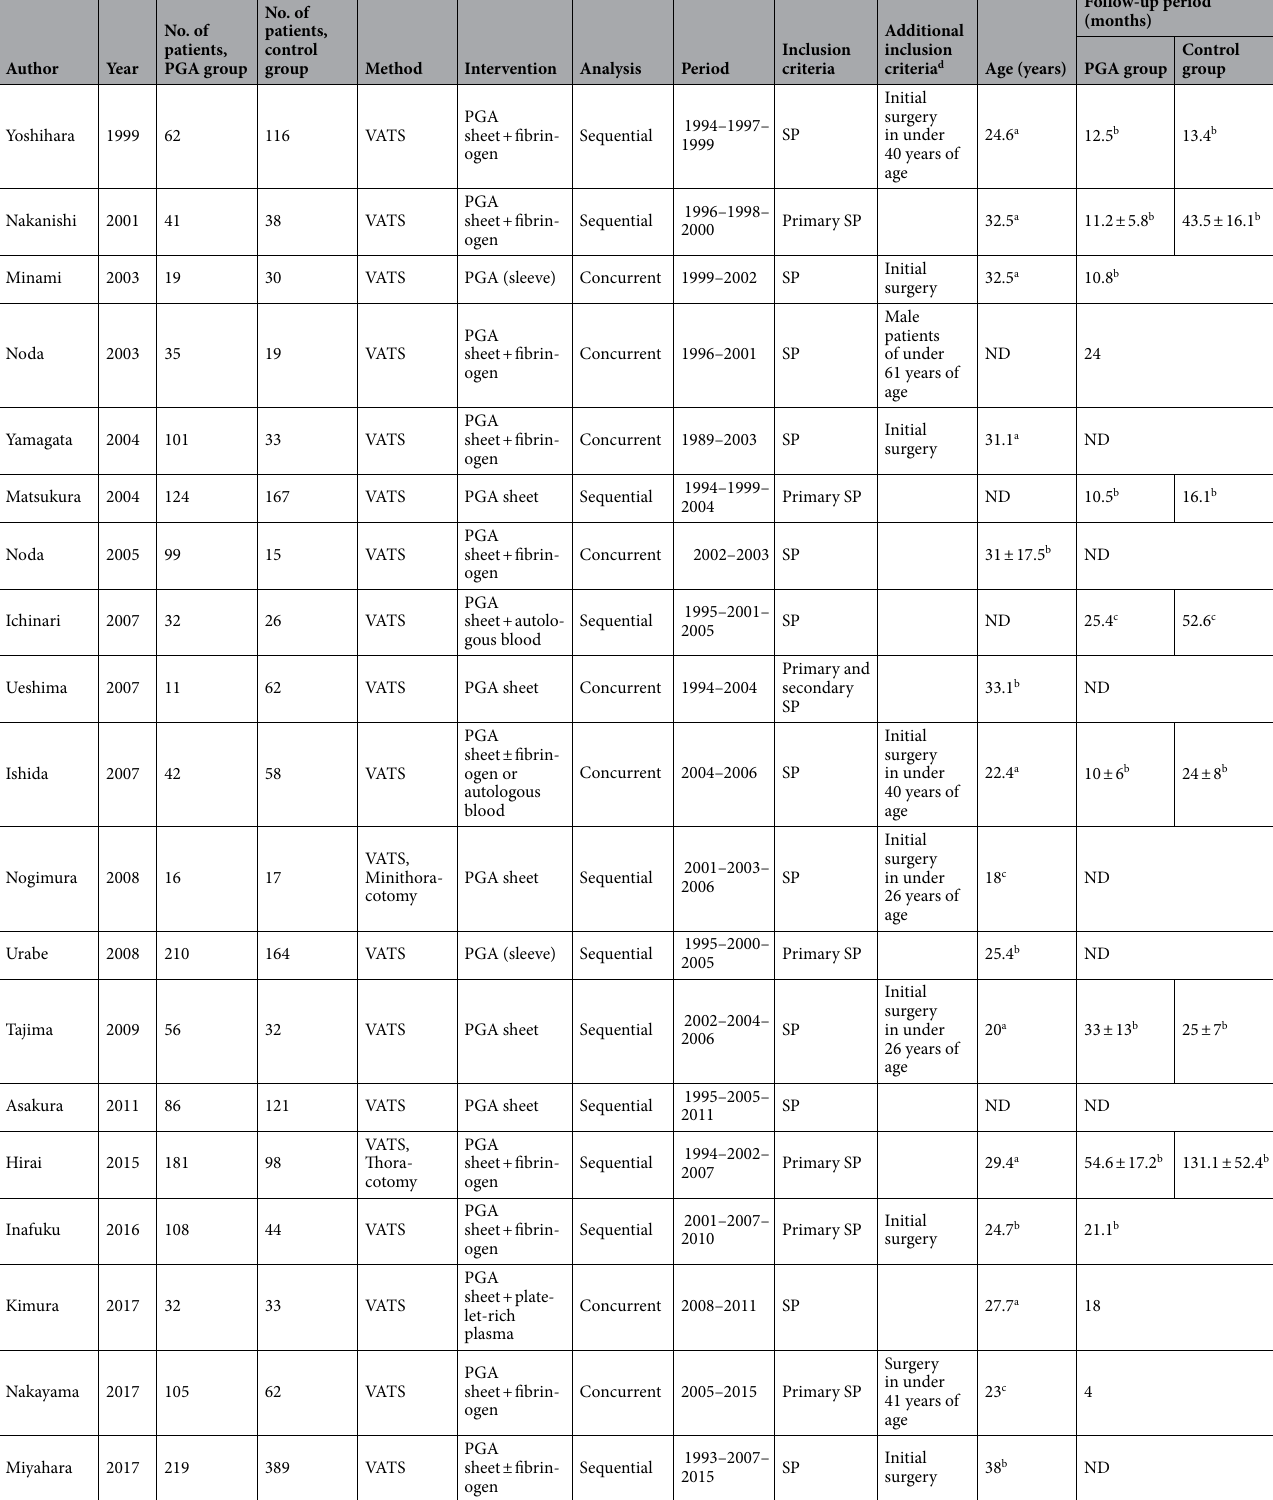
Table1. Characteristics of the included studies. PGA polyglycolic acid, SP spontaneous pneumothorax, VATS video-assisted thoracoscopic surgery, ND neither described nor discernible from the original manuscript. a Values calculated from mean age of each group. b Values of mean, or mean ± standard deviation. c Values of median. d Every study examined the patients who underwent surgery for spontaneous pneumothorax. This column shows the additional inclusion criteria that each study set for